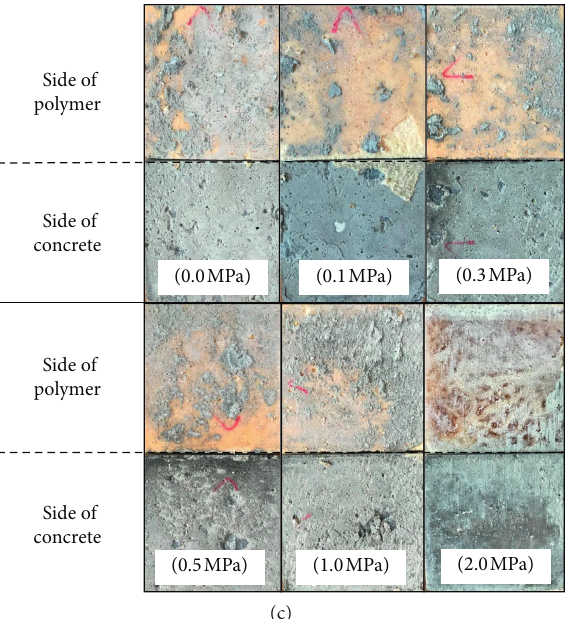
Figure 4: Typical morphology of fracture surface after bonding test. (a) Specimens of C30 without normal pressure; (b) C30P23; (c)